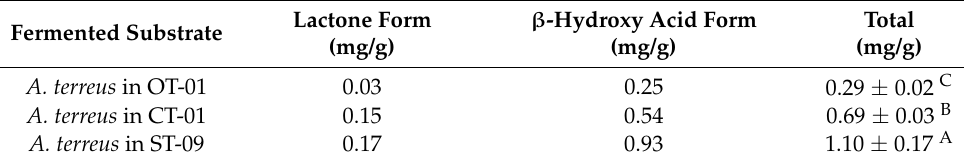
Table 5. Lovastatin content in substrates fermented by A. terreus ATCC 20542. Fermented Substrate